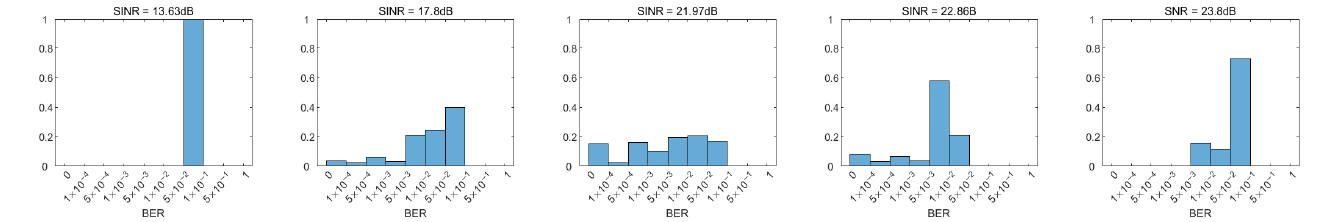
Figure 7. Histograms of a package error rate of DP-VLC